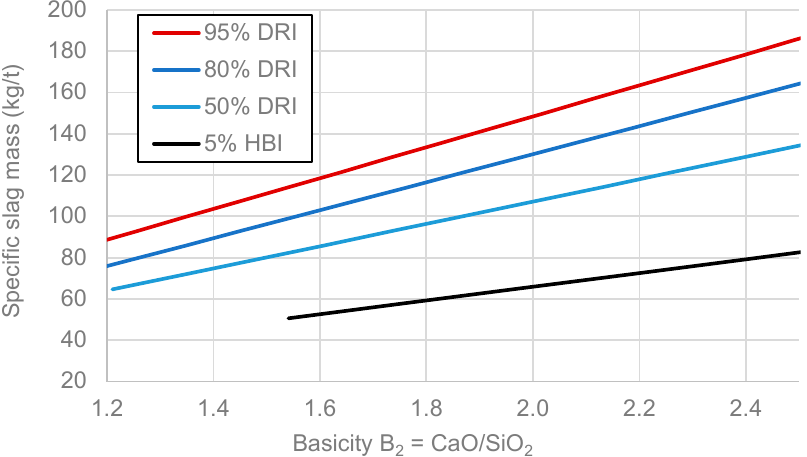
Figure 3. Specific slag volume as a function of slag basicity (x CaO /x SiO2 ) for various ratios of DRI/hot briquetted iron (HBI) to steel scrap (assuming 2.5% SiO 2 and 0.5% CaO in DRI and 33% CaO in slag, Equation (1)).